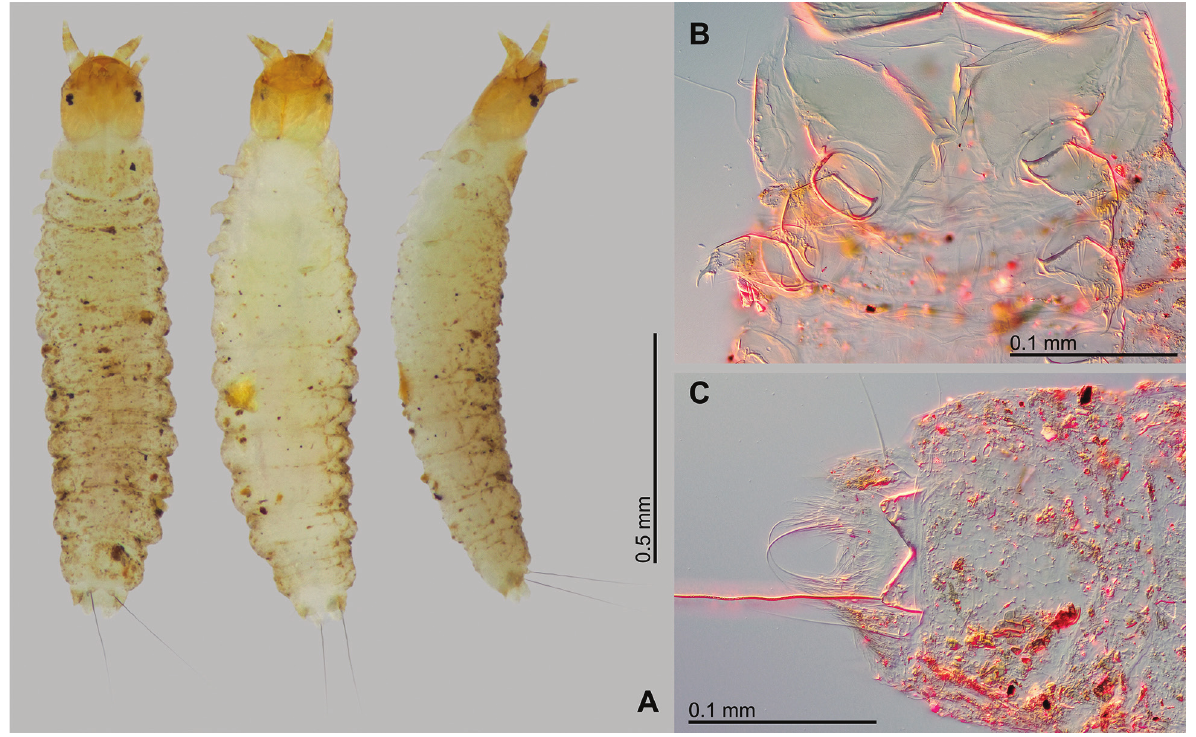
Figure 1. Larva of Psalitrus yamatensis Hoshina & Satô. A. Habitus, dorsal (left), ventral (middle), and lateral (right) view; B. Thorax, ventral view; C. Spiracular atrium, dorsal view.